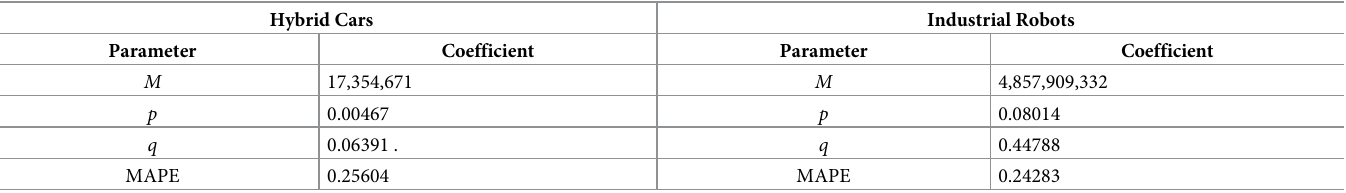
Table 3. Estimation results of Bass model.